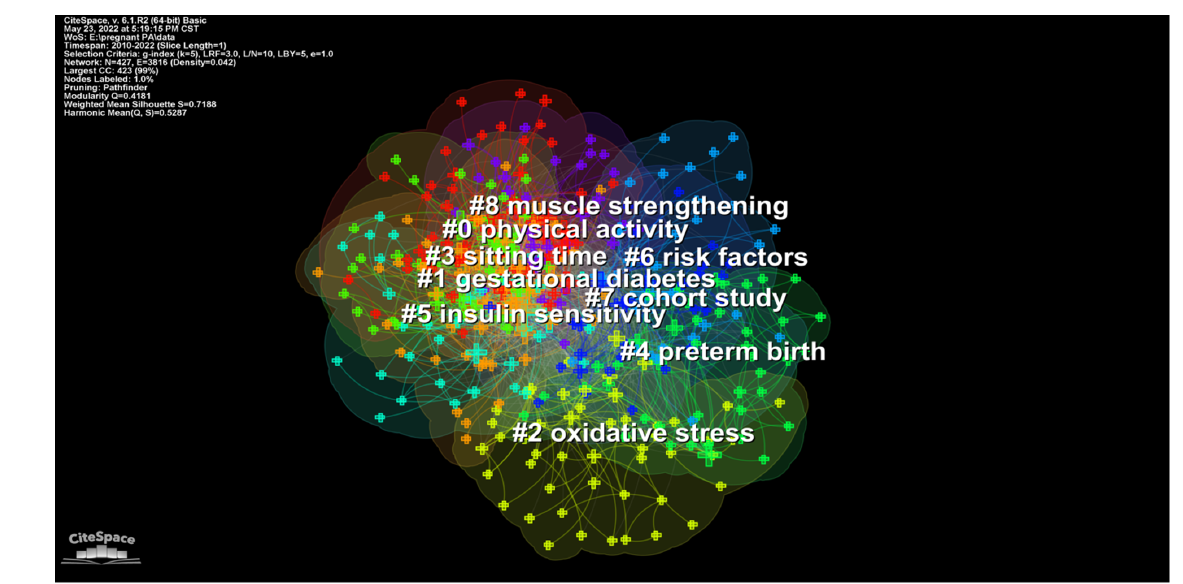
Figure 7. Co ‐ occurrence map of keywords in research of physical activity during pregnancy.